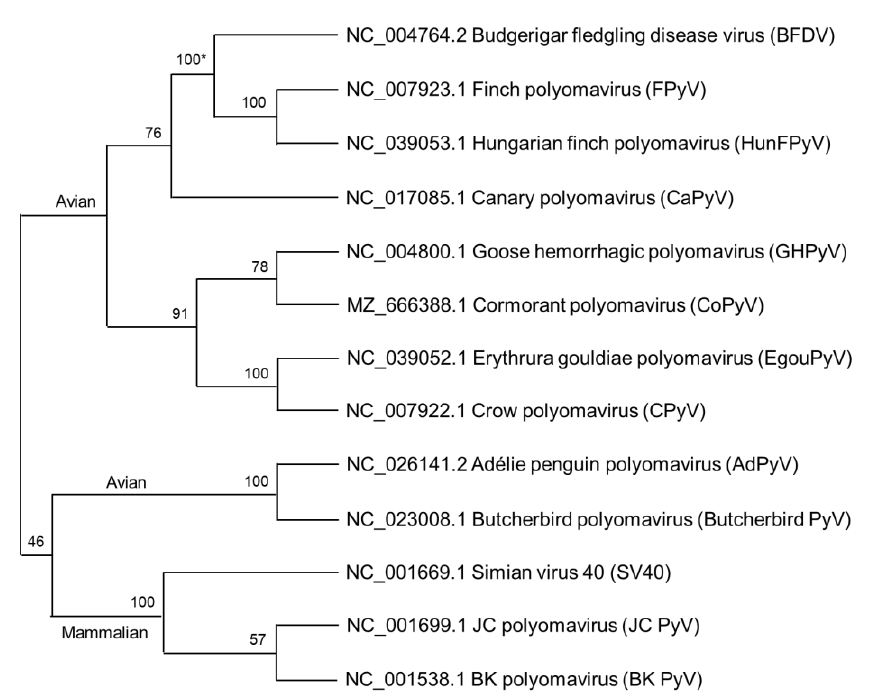
Figure 3. Phylogenetic analyses using amino acid sequences of the large T-Ag ( A ) and VP1 ( B ) from the Gammapolyomaviruses. The phylogeny, which uses the large T-Ag, can distinguish between APVs and MPVs. Interestingly, using VP1 for the analysis, Butcherbird PyV and AdPyV show the closest relationship with MPVs on a common branch. Pathogenically, their clinical symptoms are mild and there is no mortality (Table 2) [28,29]. Virus names and GenBank accession numbers are shown on the phylogenetic tree. * The bootstrap value on the branch represents the percentage while using 1000 bootstrap replicates.